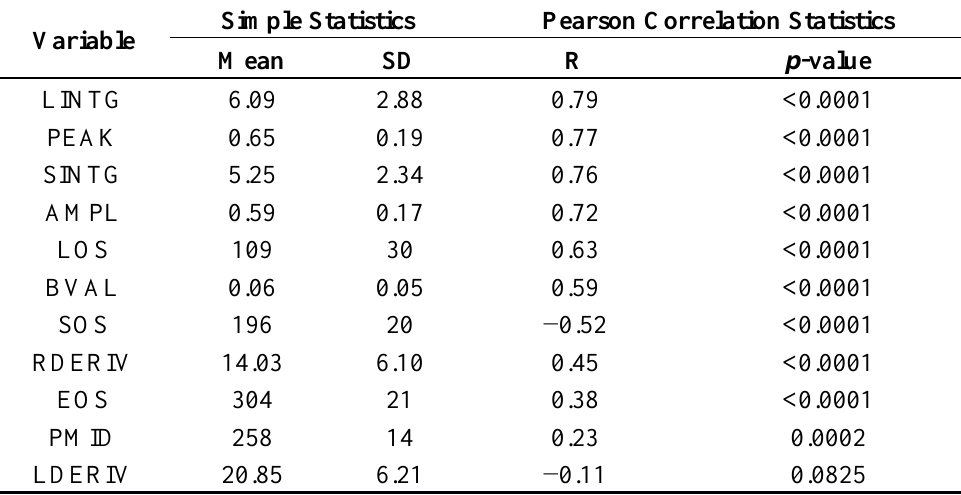
Table 4. Mean values, standard deviation (SD), and Pearson correlation statistics of the phenological variables with total biomass collected in the 1999–2013 period ( n = 263). The variables LOS, SOS, EOS, and PMID are expressed in number of days. For acronyms, see Table